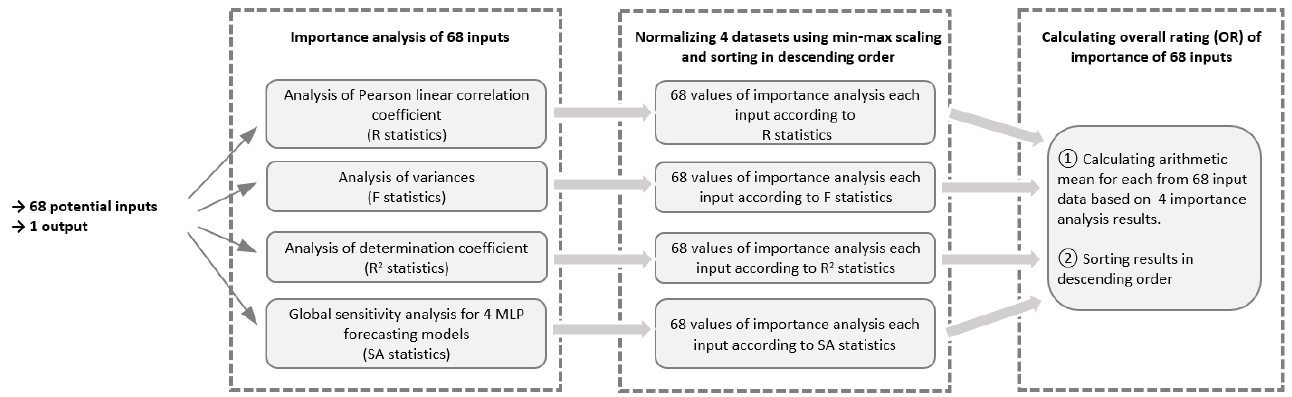
Figure 9. Consecutive steps of potential input data sensitivity analysis of made with 4 different methods and Overall Rating (OR).